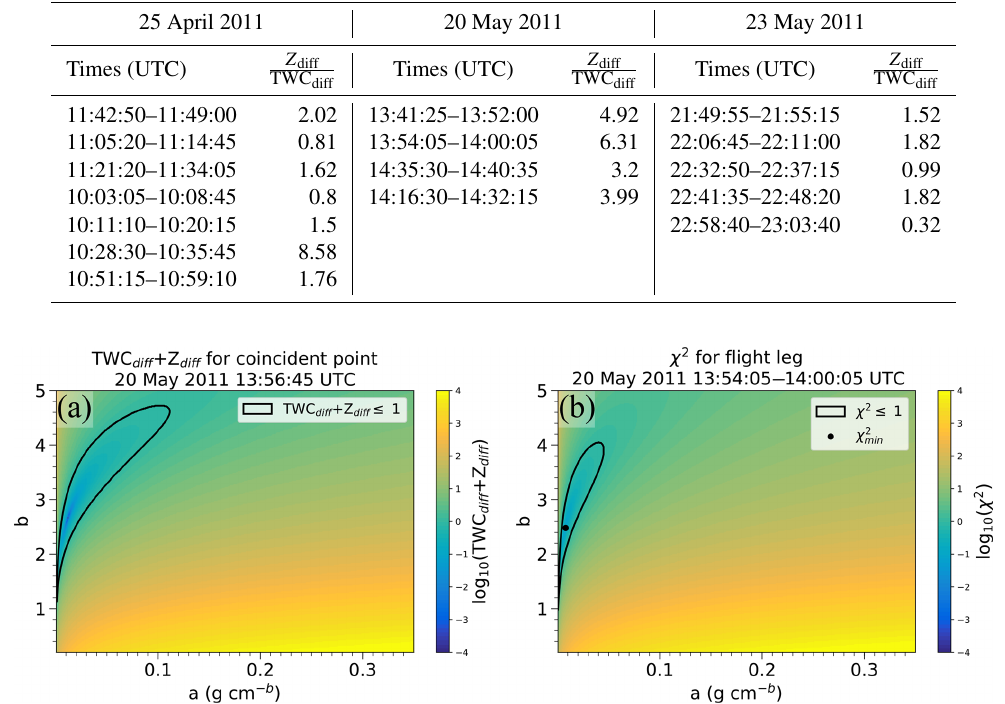
Figure 2. TWC diff + Z diff in ( a,b ) phase space for (a) a 10s coincident point beginning at 13:56:15UTC on 20 May 2011, (b) integrated over the encompassing flight leg between 13:54:14 and 13:59:35UTC, and normalized by the number of observations N . The black dot in (b) denotes the a and b minimizing χ 2 .